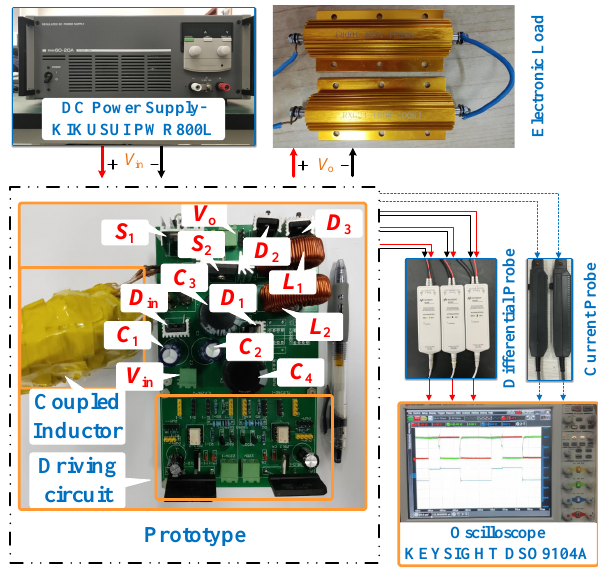
Figure 7. Prototypes with the experimental environment. Table 3. Experimental